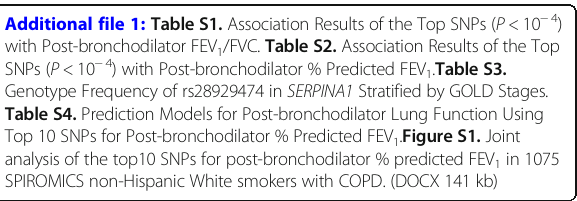
Abbreviations COPD: Chronic obstructive pulmonary disease; FEV 1 : Forced expiratory volume in 1 s; GWAS: Genome-wide association studies; SPIROMICS: